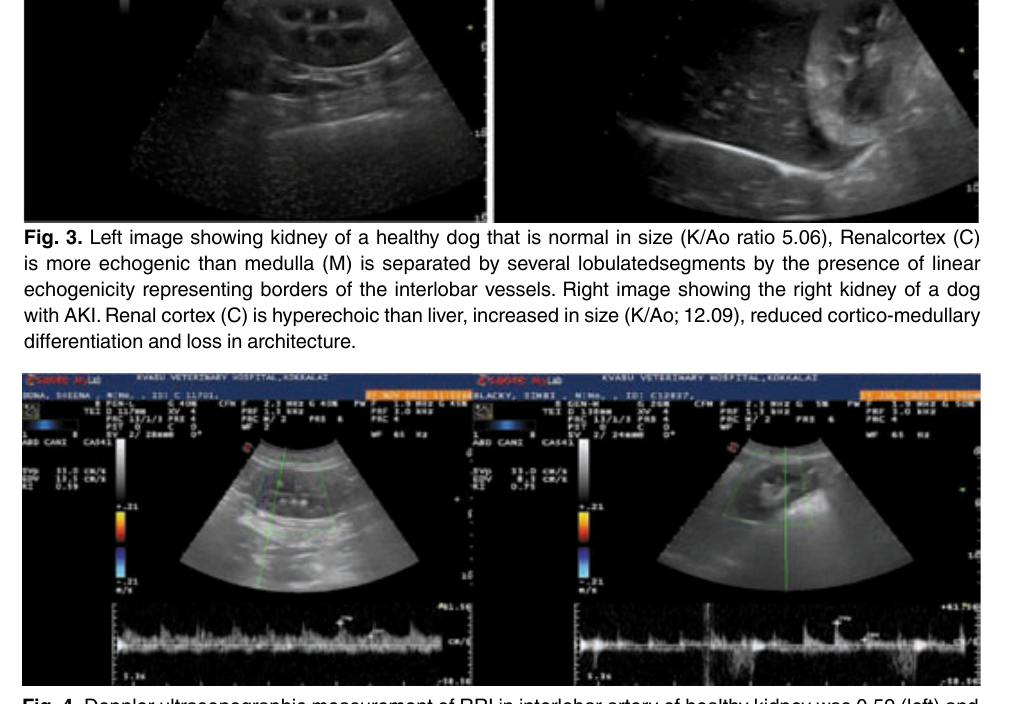
Fig. 4. Doppler ultrasonographic measurement of RRI in interlobar artery of healthy kidney was 0.59 (left) and 0.75 in AKI